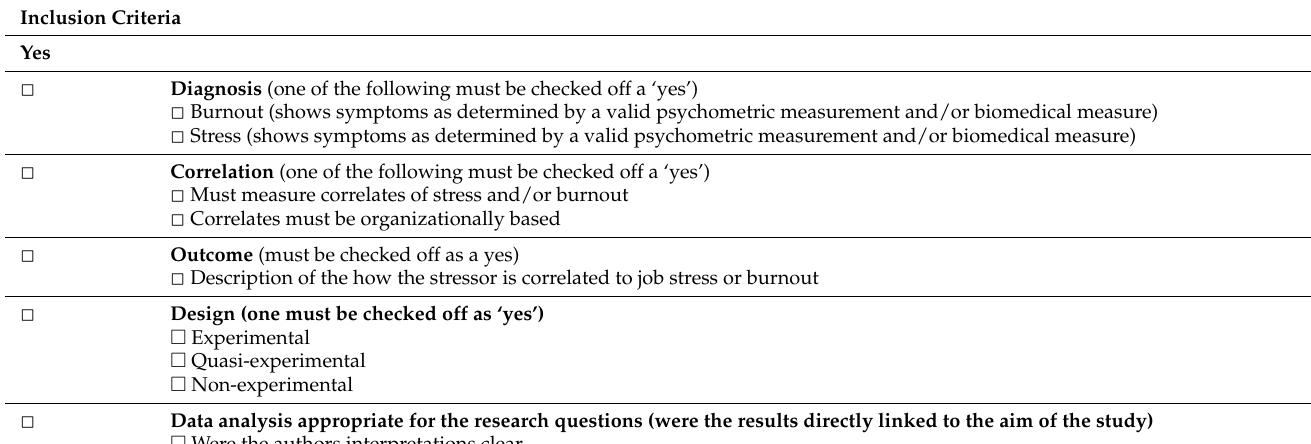
Table 4. Stage 2 Quality Assessment